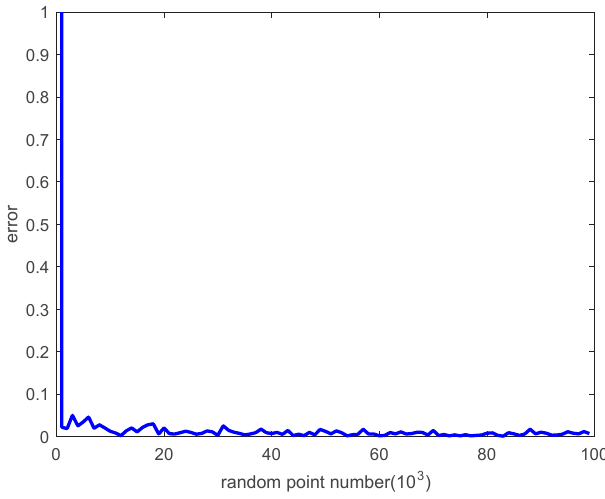
( b ) Figure 10. Two situations of null set. ( a )